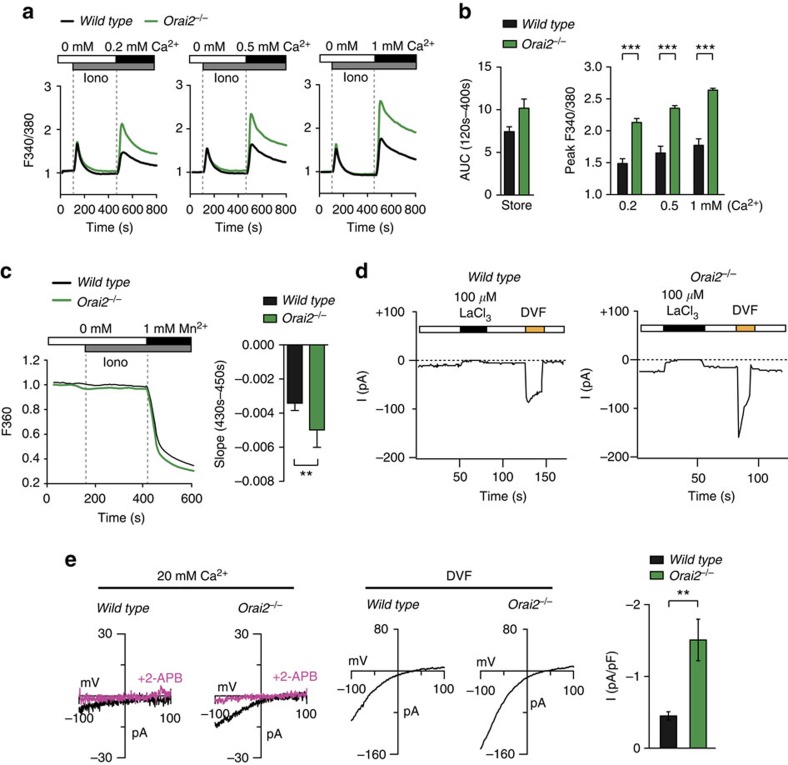
Orai2-deficient macrophages have increased SOCE and CRAC currents.(a,b) Analysis of SOCE following ionomycin stimulation in WT and Orai2-deficient bone marrow-derived macrophages (BMDMs) after readdition of 0.2, 0.5 and 1 mM extracellular Ca2+ using a FlexStation plate reader. (b) Quantification of store depletion (AUC120 s–400 s) and SOCE (F340/380 peak) as shown in a; means±s.e.m. of three mice. (c) Mn2+ quenching of Fura-2 fluorescence to measure store-operated divalent cation influx via CRAC channels. WT and Orai2-deficient BMDMs were loaded with Fura-2 and stimulated with 0.3 μM ionomycin in Ca2+ and Mn2+-free Ringer solution, followed by the addition of 1 mM Mn2+. Bar graphs show the quantification of Mn2+ quench rates in ionomycin-stimulated BMDMs normalized to unstimulated cells; means±s.e.m. of three mice. (d,e) Electrophysiological properties of CRAC currents in WT and Orai2−/− BMDMs. (d) Leak-corrected CRAC currents measured at −100 mV are plotted over time. The standard extracellular Ringer solution was periodically switched with a Na+-based DVF solution, revealing permeation of Na+ ions in the absence of extracellular divalents. ICRAC is completely inhibited by 100 μM LaCl3. (e) I–V relationship of ICRAC in 20 mM Ca2+ (left) and DVF (middle) solutions in WT and Orai2−/− BMDMs and inhibition by 50 μM 2-aminoethoxydiphenyl borate (2-APB). Means±s.e.m. of the peak current density in WT and Orai2−/− BMDMs; 10–12 cells were analysed (right). *P<0.05; **P<0.005; ***P<0.001 in (b,c,e) using unpaired Student's t-tests.